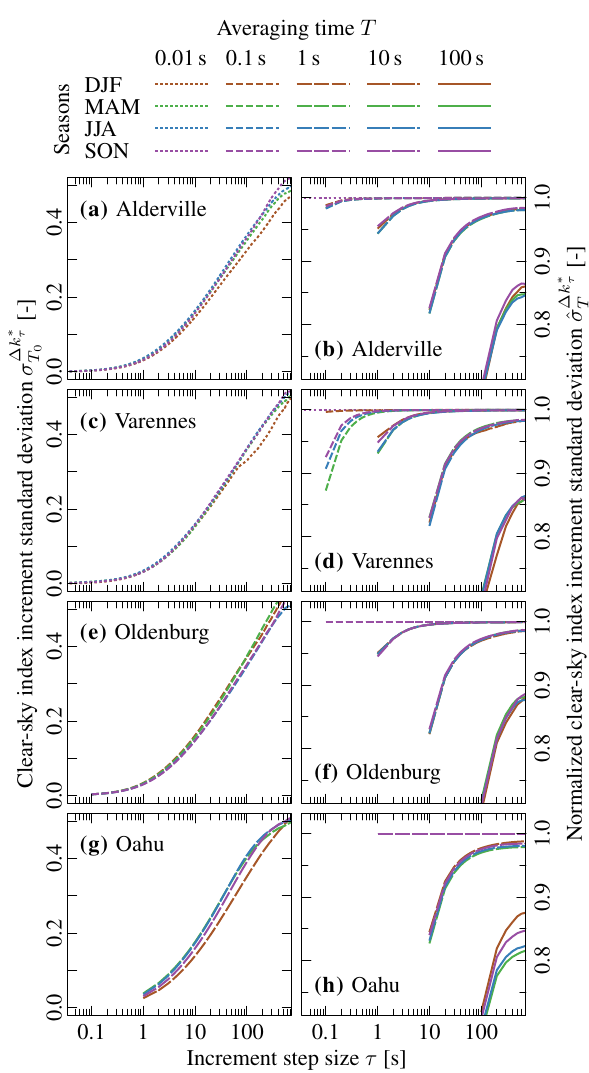
Figure 7. As in Fig. 6, for structures separately estimated for winter (December, January, February; DJF), spring (March, April, May; MAM), summer (June, July, August; JJA), and autumn (September, October, November; SON). The spread across single-sensor struc- tures is comparable to that in Fig. 6, but it is not shown here for the sake of facility of